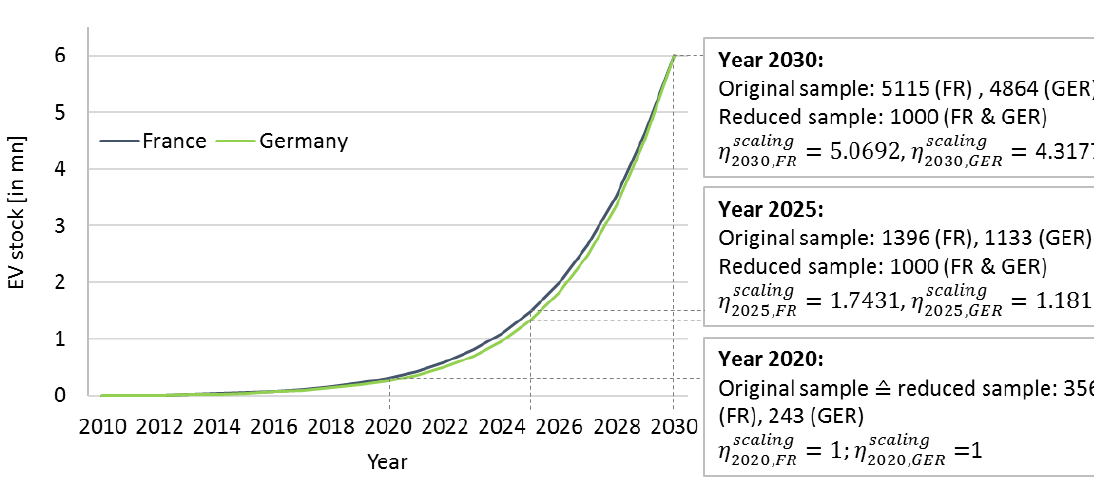
Figure 2. PEV di ff usion scenarios for France and Figure 2. PEV diffusion scenarios for France and Germany.